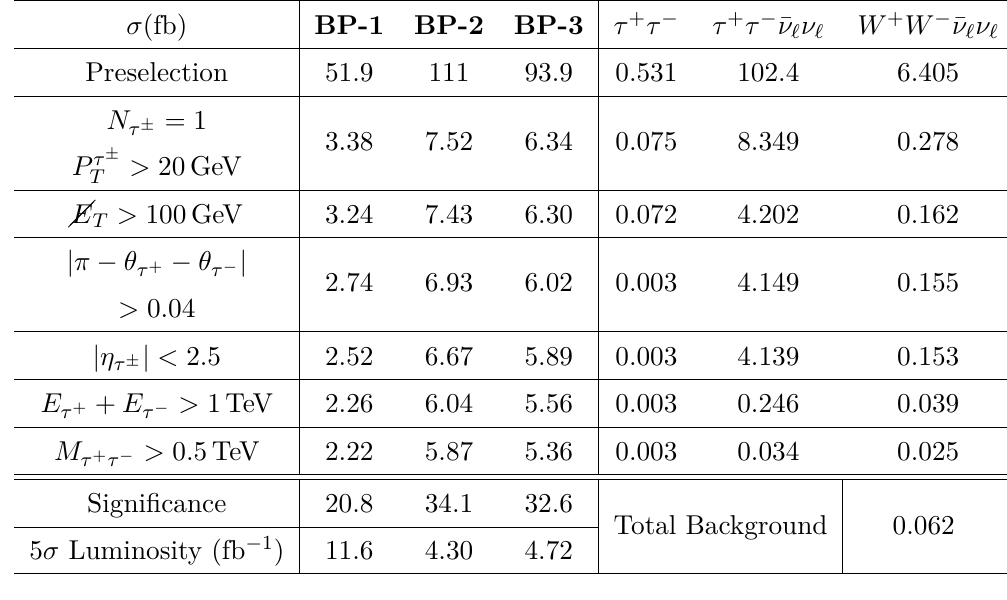
Table 3 . Same as table 2, but for the τ + τ − + (cid:0) E T signature. In this channel, we do not apply cut on | ~P + ~P | τ + τ −